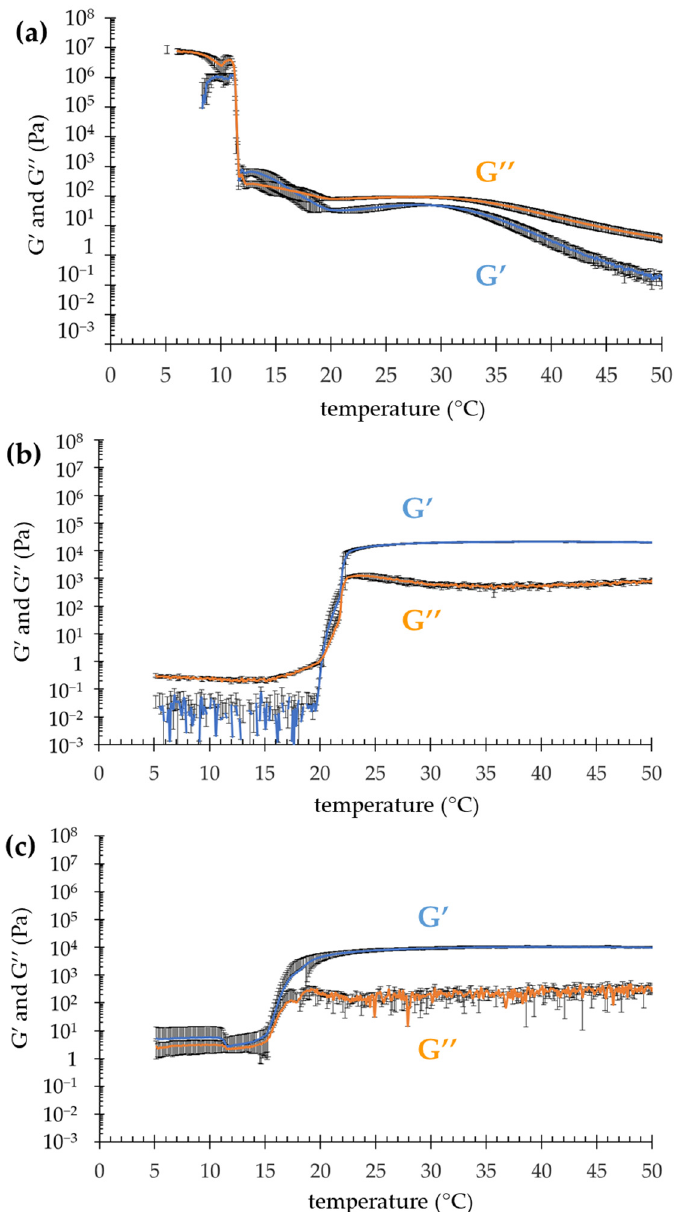
Figure 1. Evolution of elastic (G ′ ) and viscous (G ″ ) moduli as a function of temperature for OG ( a ), POL ( b ) and POG ( c ).